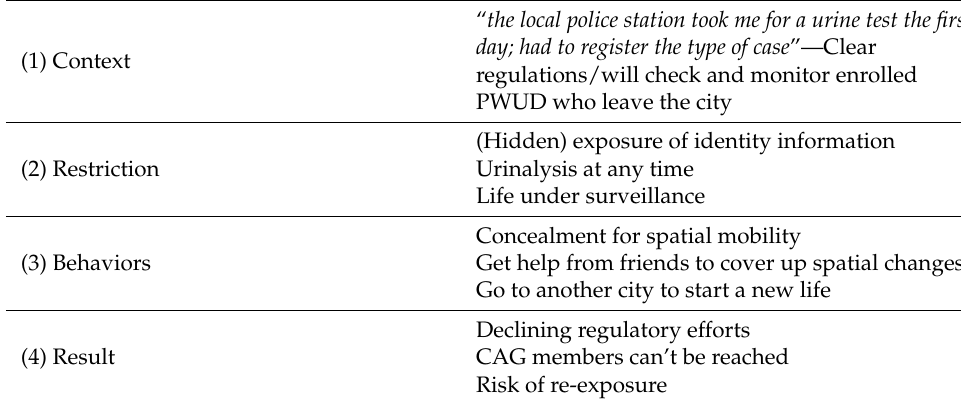
Table A3. Recoding by context and genera.